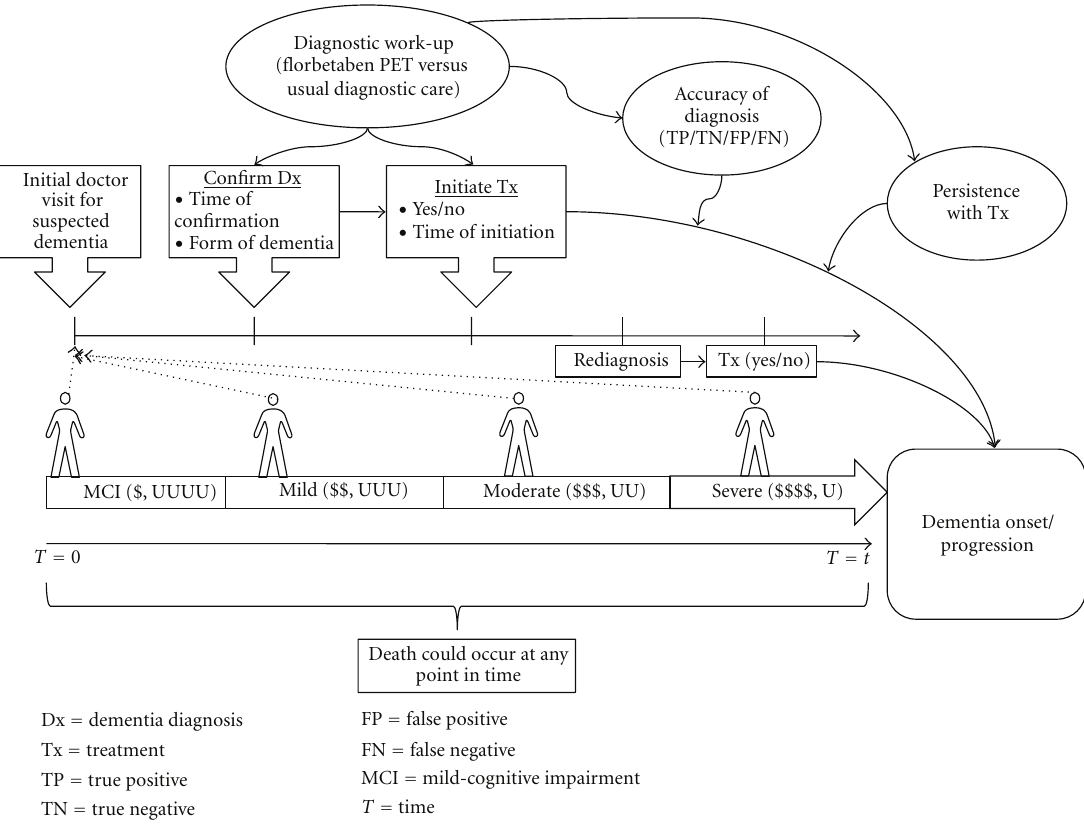
Figure 1: Schematic representation of the model